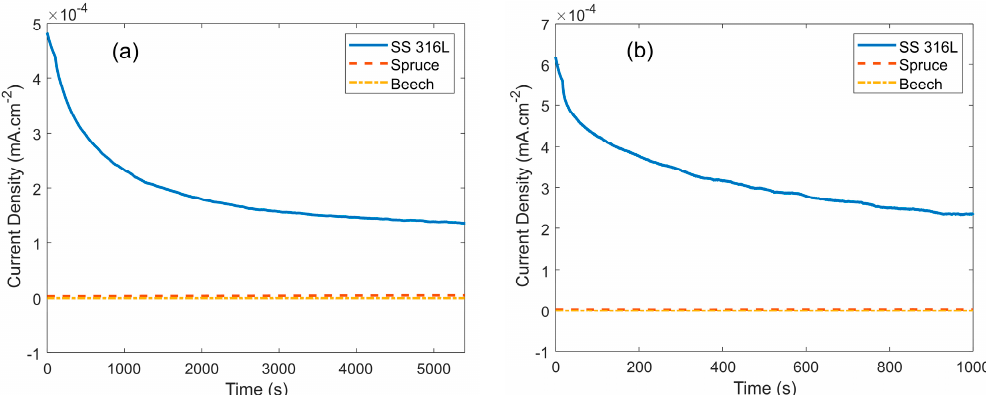
Figure 5. FTIR transmittance spectra of the carboxymethyl bands in beech ( a ) and spruce ( b ) lignin coated samples before and after annealing at 120 °C.